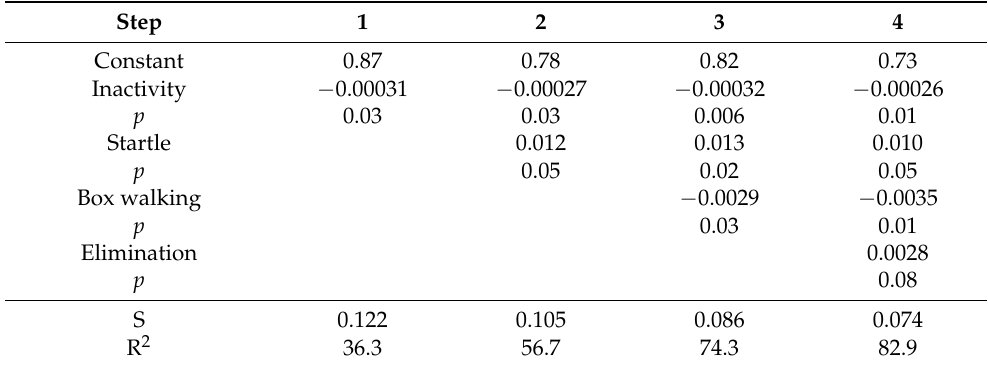
Table 5. Stepwise regression coefficients and probability values for 4 steps of correlating 26 behaviours with the TBRWI.